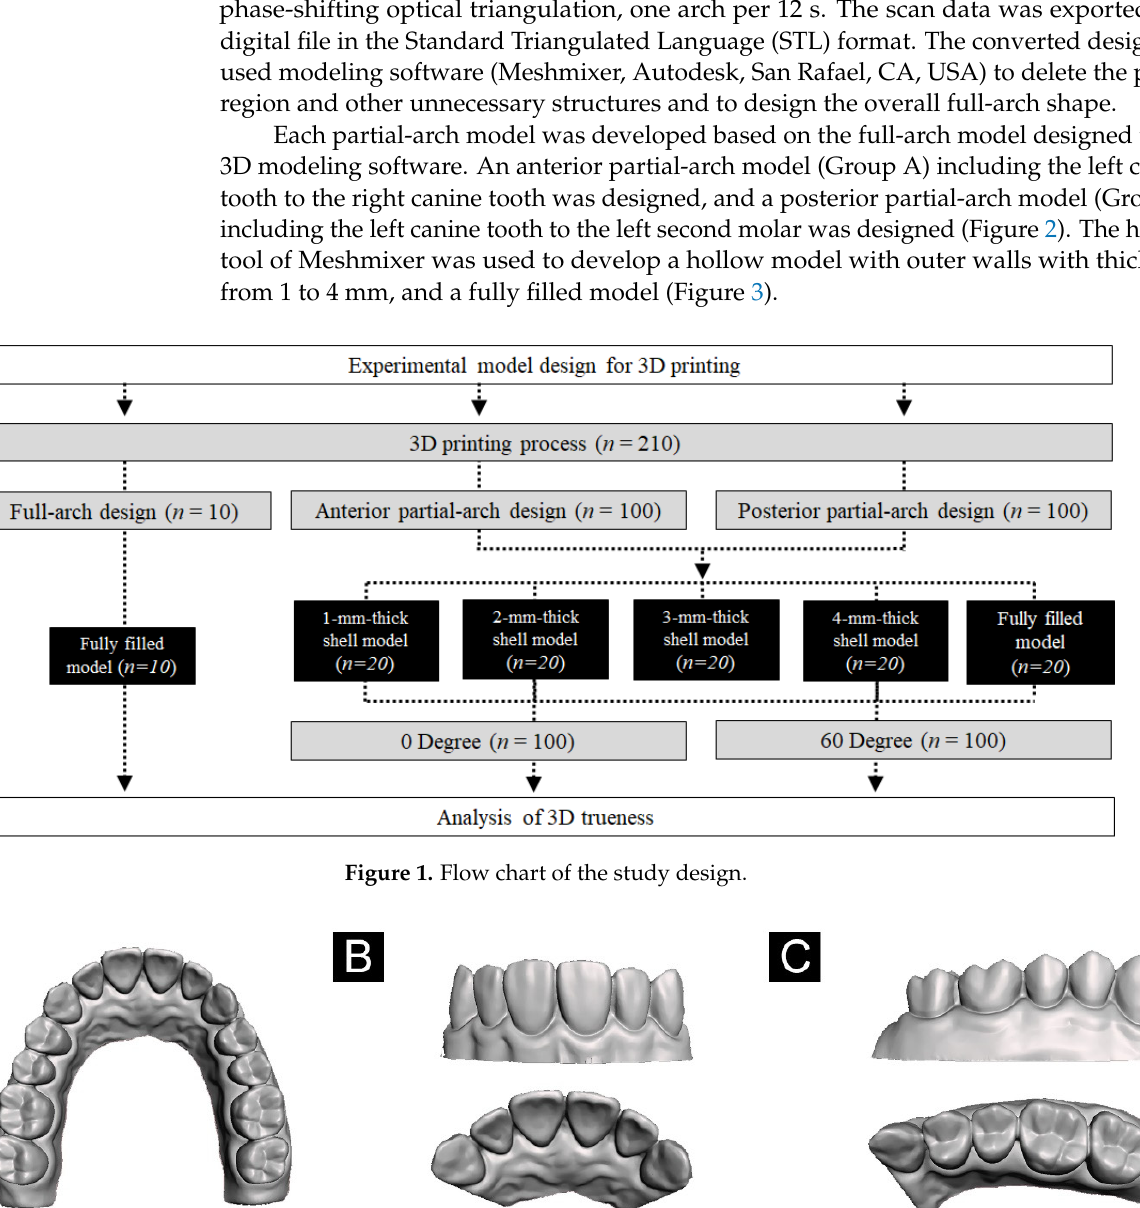
Figure 2. Designs of the ( A ) full-arch model, ( B ) anterior partial-arch model, and ( C ) posterior partial-arch model. Partial areas of the teeth and gingiva were designated and used to evaluate printing accuracy.